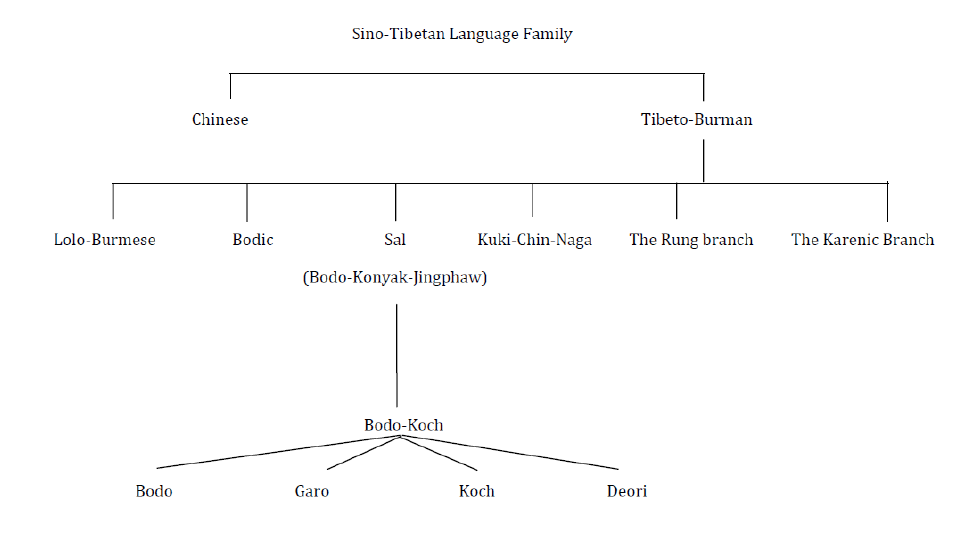
Figure 1: Tibeto-Burman genealogy (based on Thurgood and LaPolla 2003 and Burling